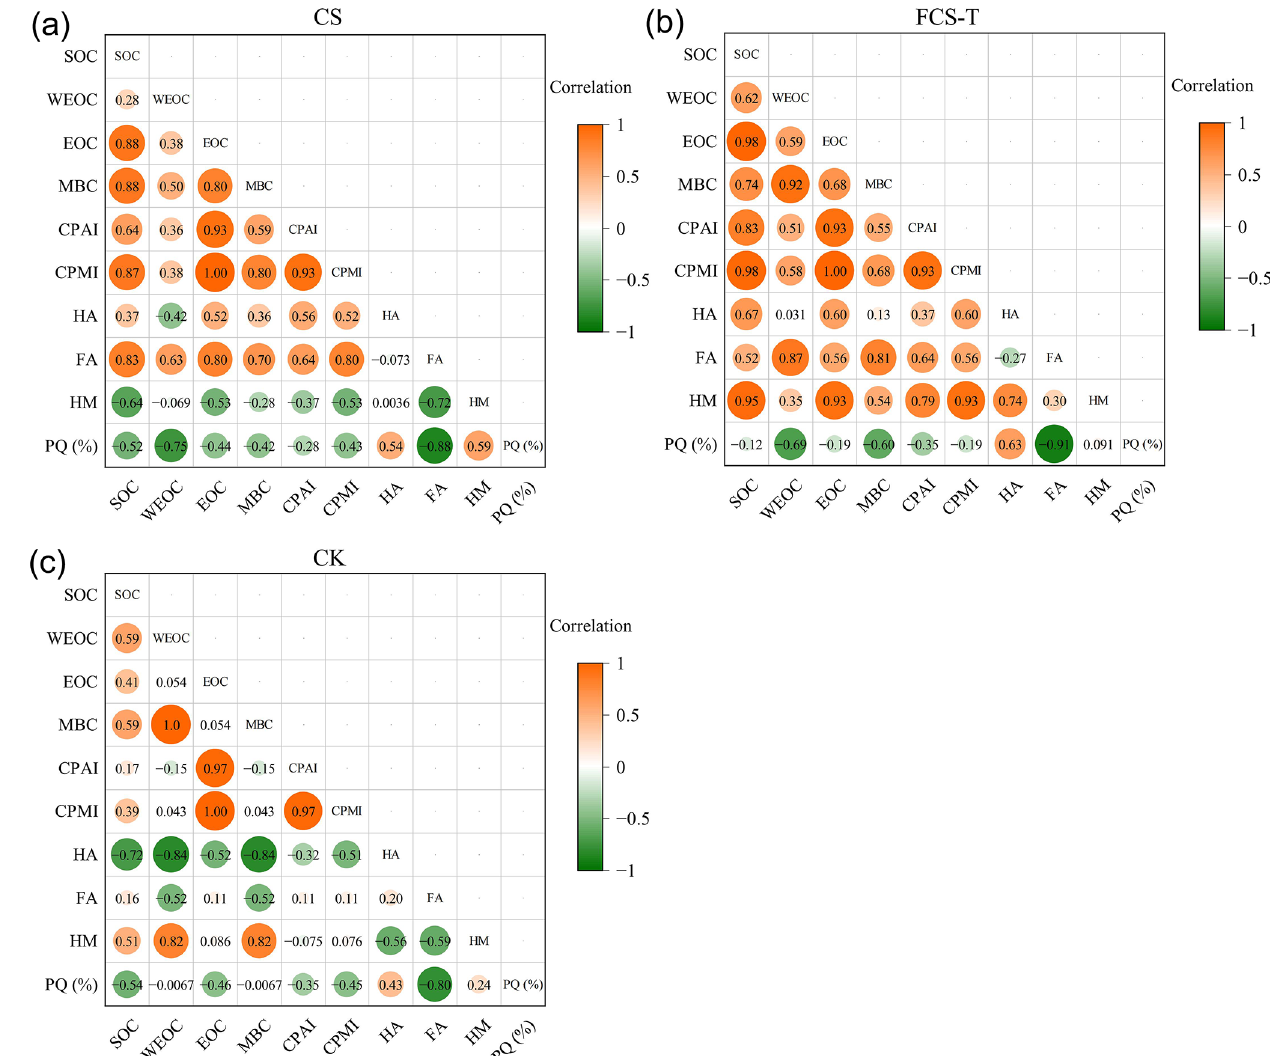
Figure 7. The heatmap of Pearson’s correlations among soil parameters from different treatments soil during the 360d of the experiment ( a : CS; b : FCS-T; c :